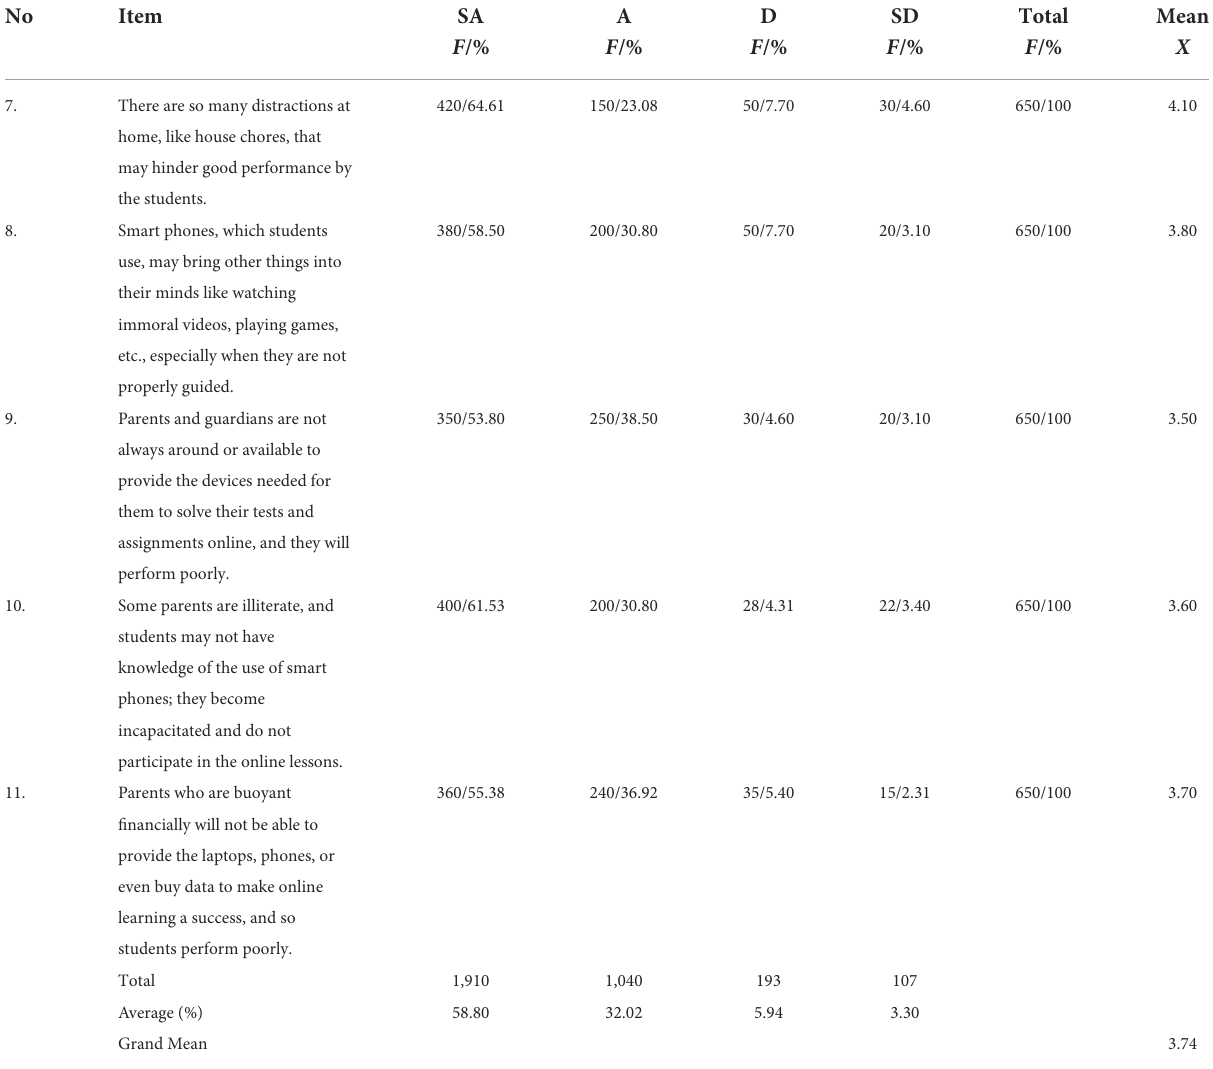
TABLE 2 Responses to the impacts of the external environment on APs compared to traditional face-to-face